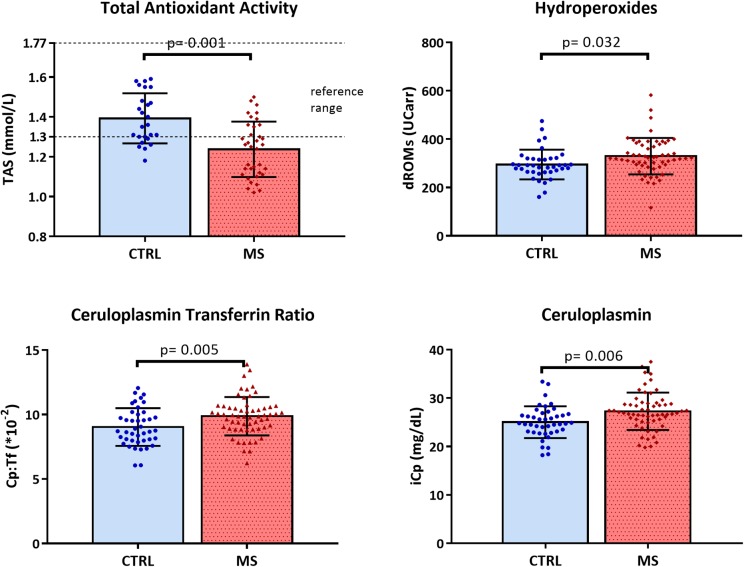
Scattered dot plot with bar plot (mean with SD) of total antioxidant status (TAS), hydroperoxides (dROMs), ceruloplasmin transferrin ratio (Cp:Tf), and ceruloplasmin (iCp) in CTRL and MS.